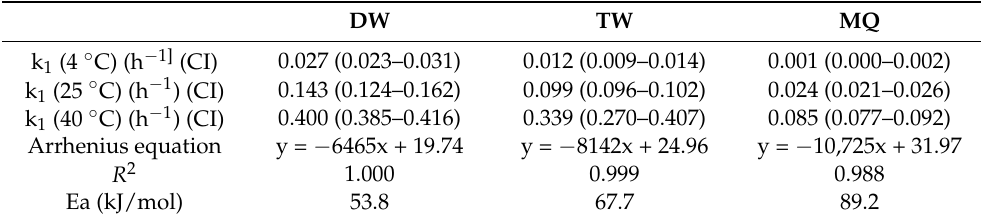
Table 4. First-order rate constants for vitamin D3 at various temperatures in Milli-Q (MQ), distilled (DW), and tap water (TW), along with the Arrhenius equation.